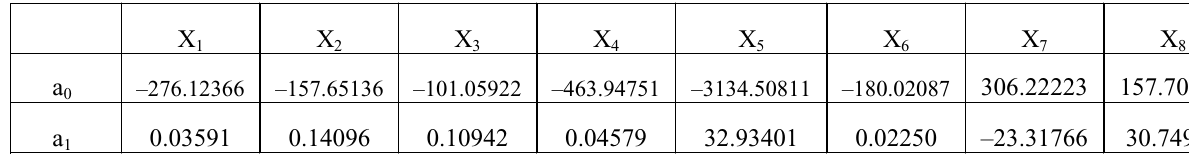
Table 4 . Single linear regression